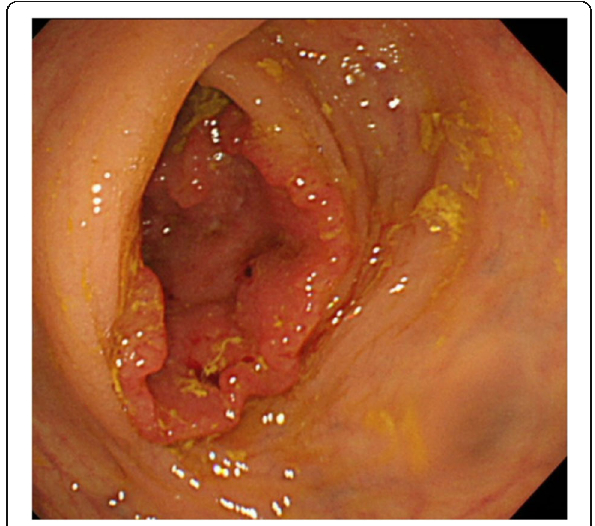
Fig. 2 Colonoscopy revealed type 2 rectal tumor located 12 cm from the anal verge. Background mucosa did not show edematous changes or ulcerative and hemorrhagic